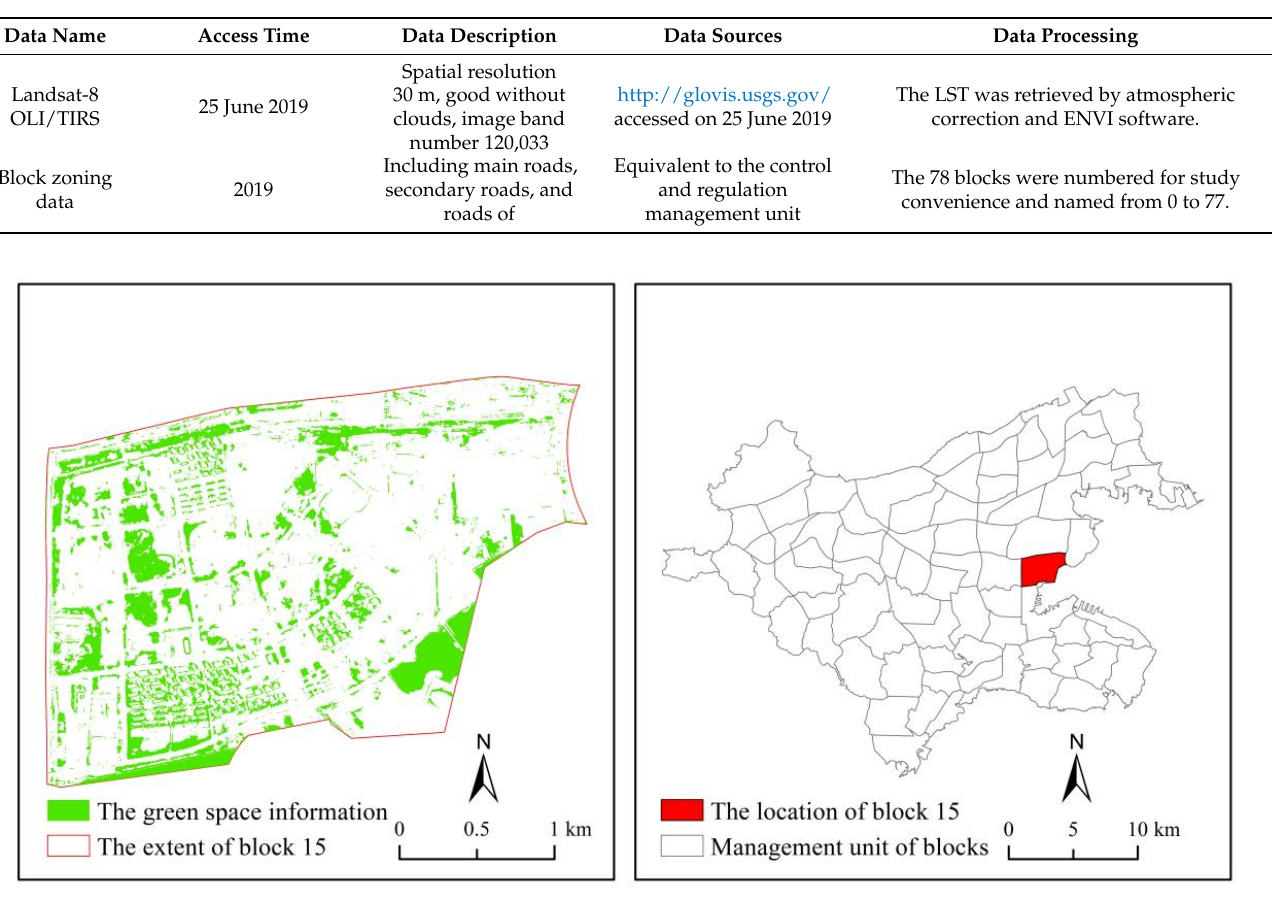
Figure 3. The green space information extracted from remote sensing images . Table 1. Data source and processing.